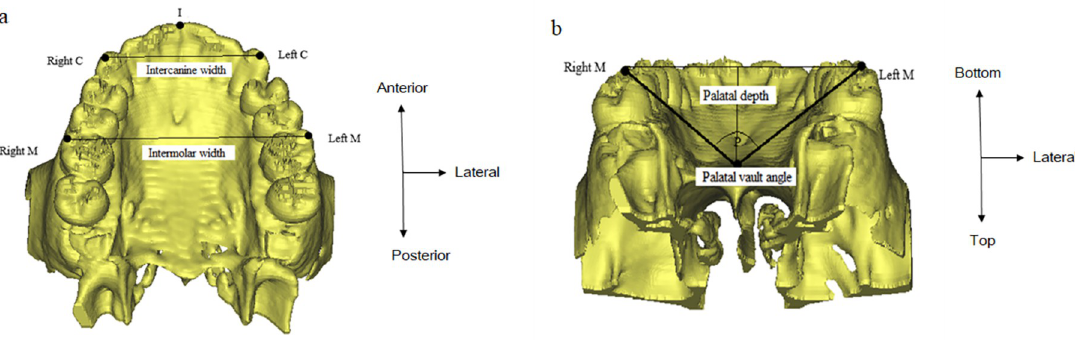
Fig 2. (A) Interdental width (B) Palatal vault angle and palatal depth. C, canine; M, mesiobuccal cusp of the maxillary first